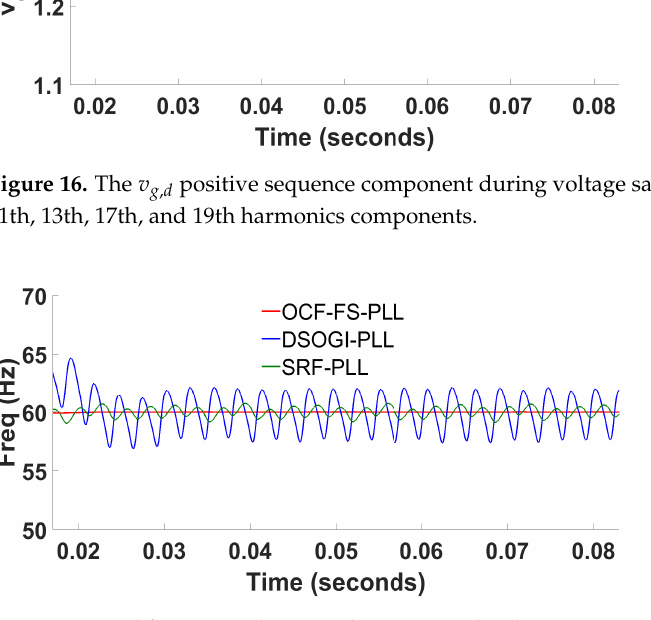
Figure 17. Grid frequency during voltage sag under the presence 5th, 7th, 11th, 13th, 17th, and 19th harmonics components.